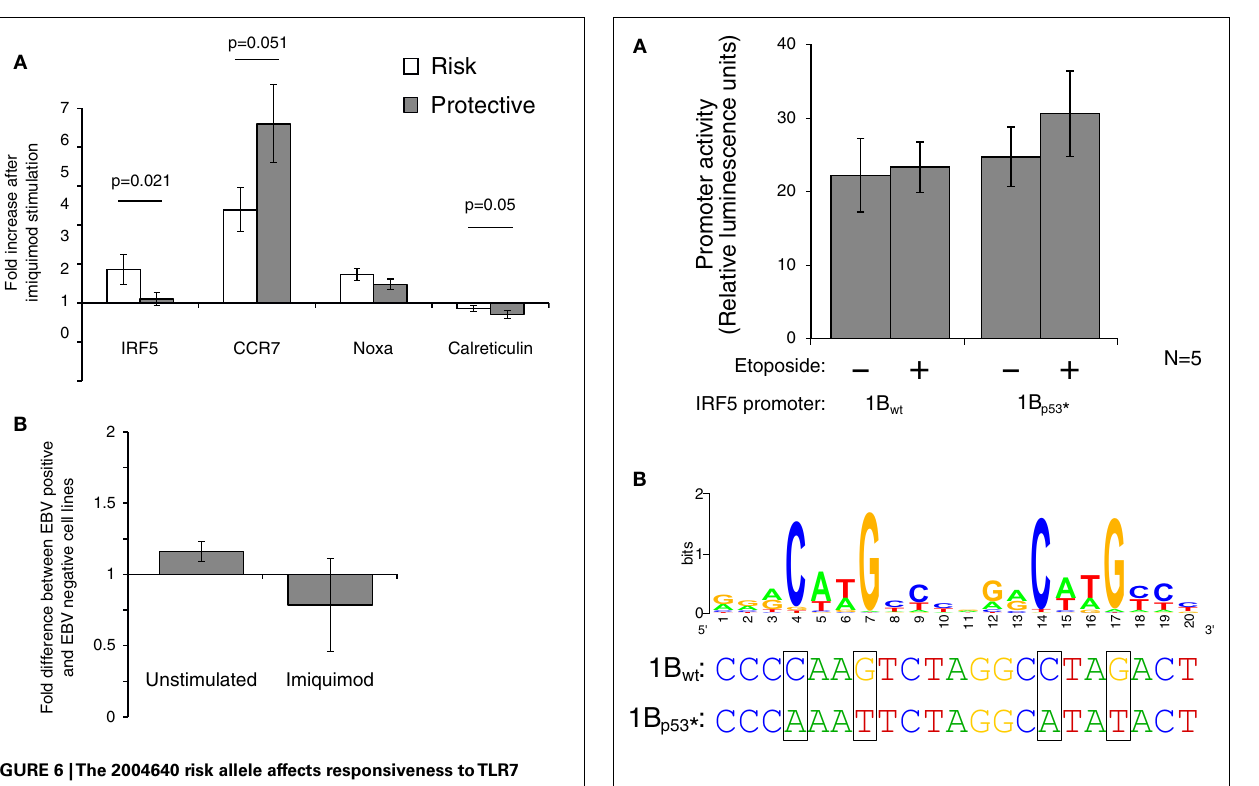
FIGURE 7 | Interferon regulatory factor 5 1B promoter activity is not regulated by direct p53 binding . (A) Different LCLs generated from healthy volunteers were electroporated with the 1B wt or the 1B p53* promoter luciferase plasmid. Cells were treated with 0.5mM etoposide or left untreated. Despite the presence of a putative p53 binding site, DNA damaging treatment did not affect promoter activity; neither did mutation of the p53 site. (B) The putative p53 binding site in IRF5’s exon 1B promoter, with aWebLogo of the p53 consensus binding site (29) to indicate important bases and matches.The height of the base represents the frequency of that nucleotide. Site-directed mutagenesis was performed to mutate the binding site at the critical C and G bases as shown. UV, ultraviolet; wt, wild type; *,